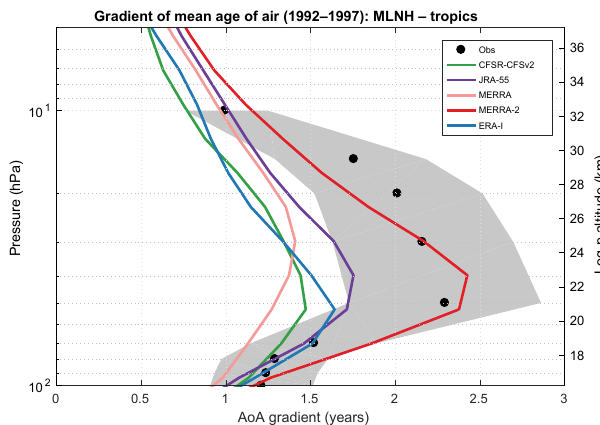
Gradient of mean age of air (1992–1997): MLNH – tropics